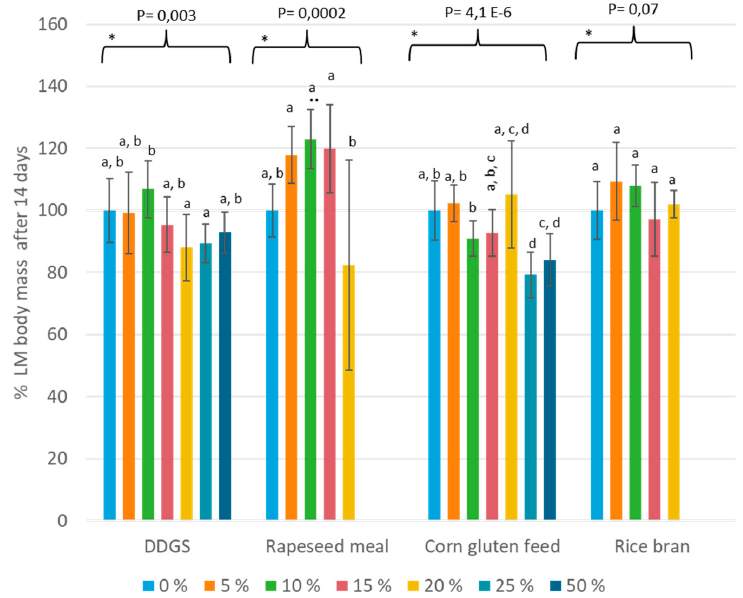
Figure 3. Percentage larval weight after 14 days of rearing for the mixed diets. The bars indicate the percentage of wheat middlings that was replaced by the side-stream, where 0% refers to the reference diet ( n = 8). * Within this data set, averages that are not labeled with the same letter are significantly different on the basis of the ANOVA-Tukey analyses. The average of the reference diet that was included in the same trial was used as the denominator in Equation (2). This data had a P -value of 0.03 for the Shapiro–Wilk test.